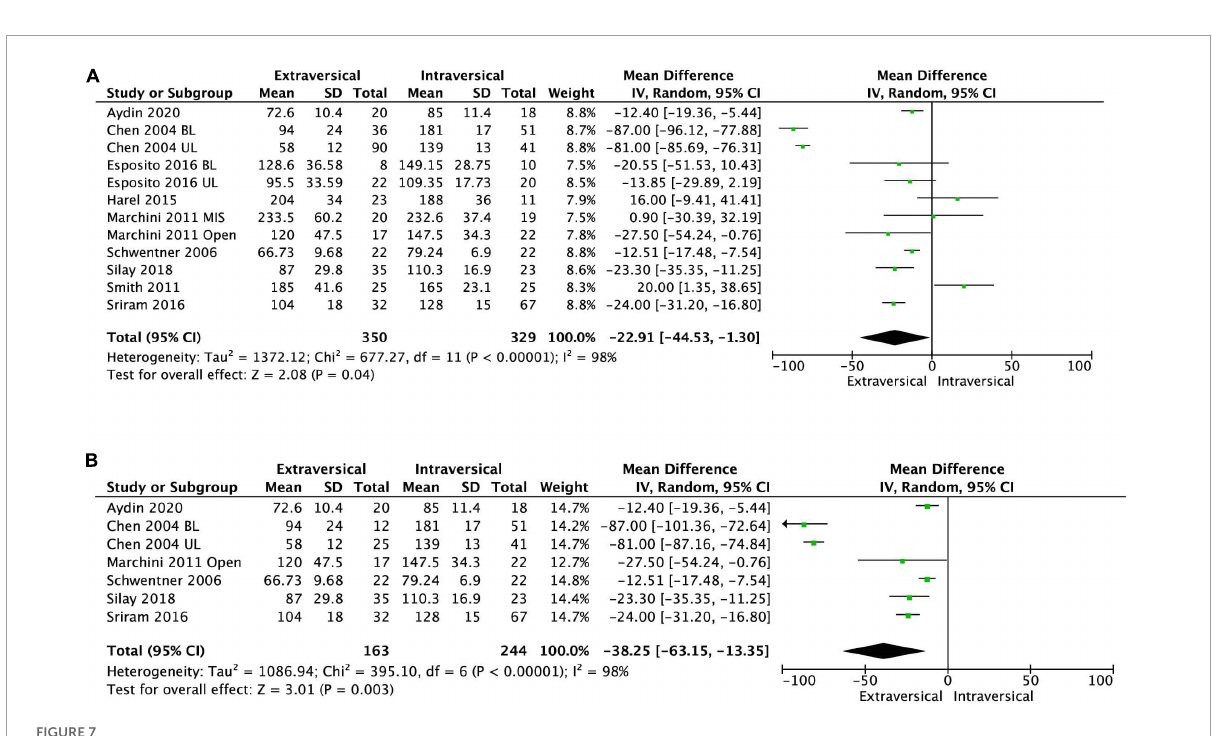
FIGURE7 Forest plot of operative time after (A) EVUR vs. IVUR for VUR in general and (B) open EVUR vs. open